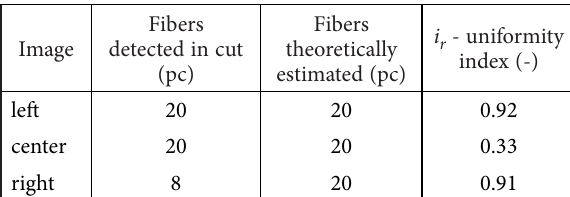
Figure 7. Illustrative placement of fibers on cutting surface. Green colour-image centroid Orange colour-centroid of the fibers Table 1. Illustrative expression of various types of placement